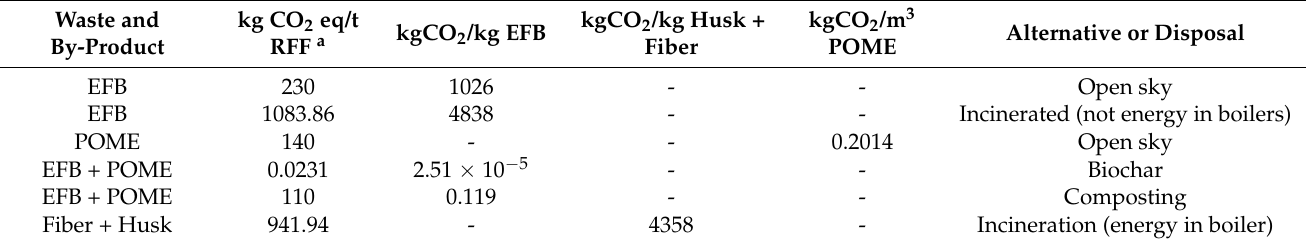
Table 10. Palm oil waste and by-product emission factors according to the type of alternative or